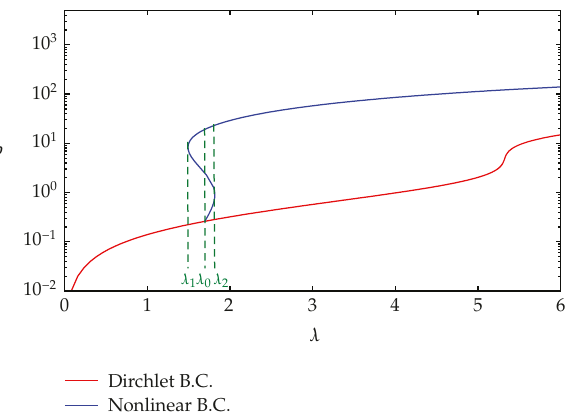
Figure 14: Graph of λ versus ρ for β (cid:3)